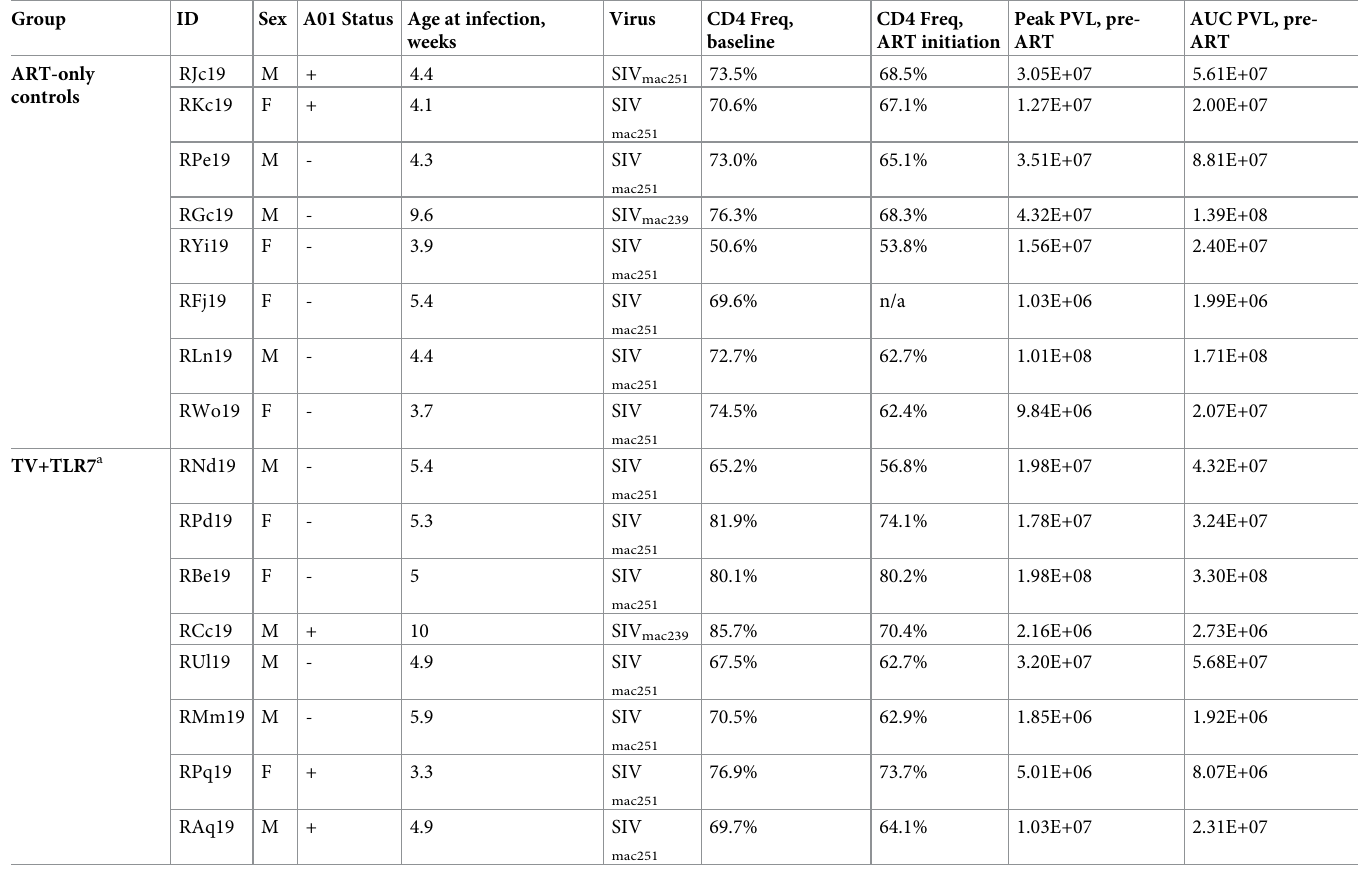
Table 1. Experimental division of SIV-infected, ART-treated infant macaques. Group Virus CD4 Freq,